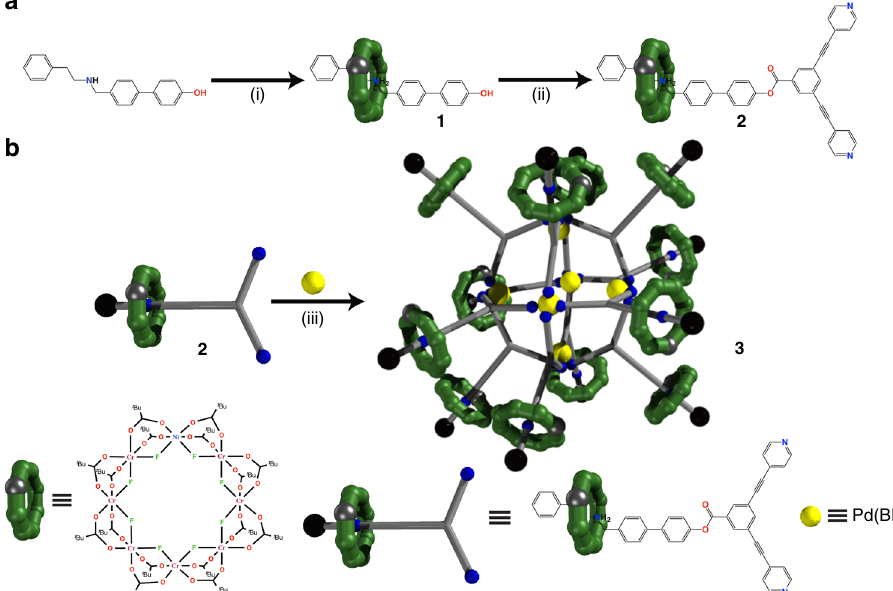
Fig. 1 Synthetic route leading to 2 and 3 . a Reaction conditions: (i) CrF 3 ·4H 2 O and [Ni 2 ( μ -OH 2 )(O 2 C t Bu) 4 (HO 2 C t Bu) 4 ], t BuCO 2 H (150 °C, 24 h); (ii) 3,5-bis (pyridin-4-ylethynyl)benzoic acid, dicyclohexylcarbodiimide and 4-(dimethylamino)pyridine, THF (r.t., 48 h, Ar) Me 2 CO (50 °C, 1 h). b Reaction conditions: (iii) [ n PrNH 3 ][Cr 7 Ni( µ -F) 8 (O 2 C t Bu) 16 ] in acetone (50 °C, 12